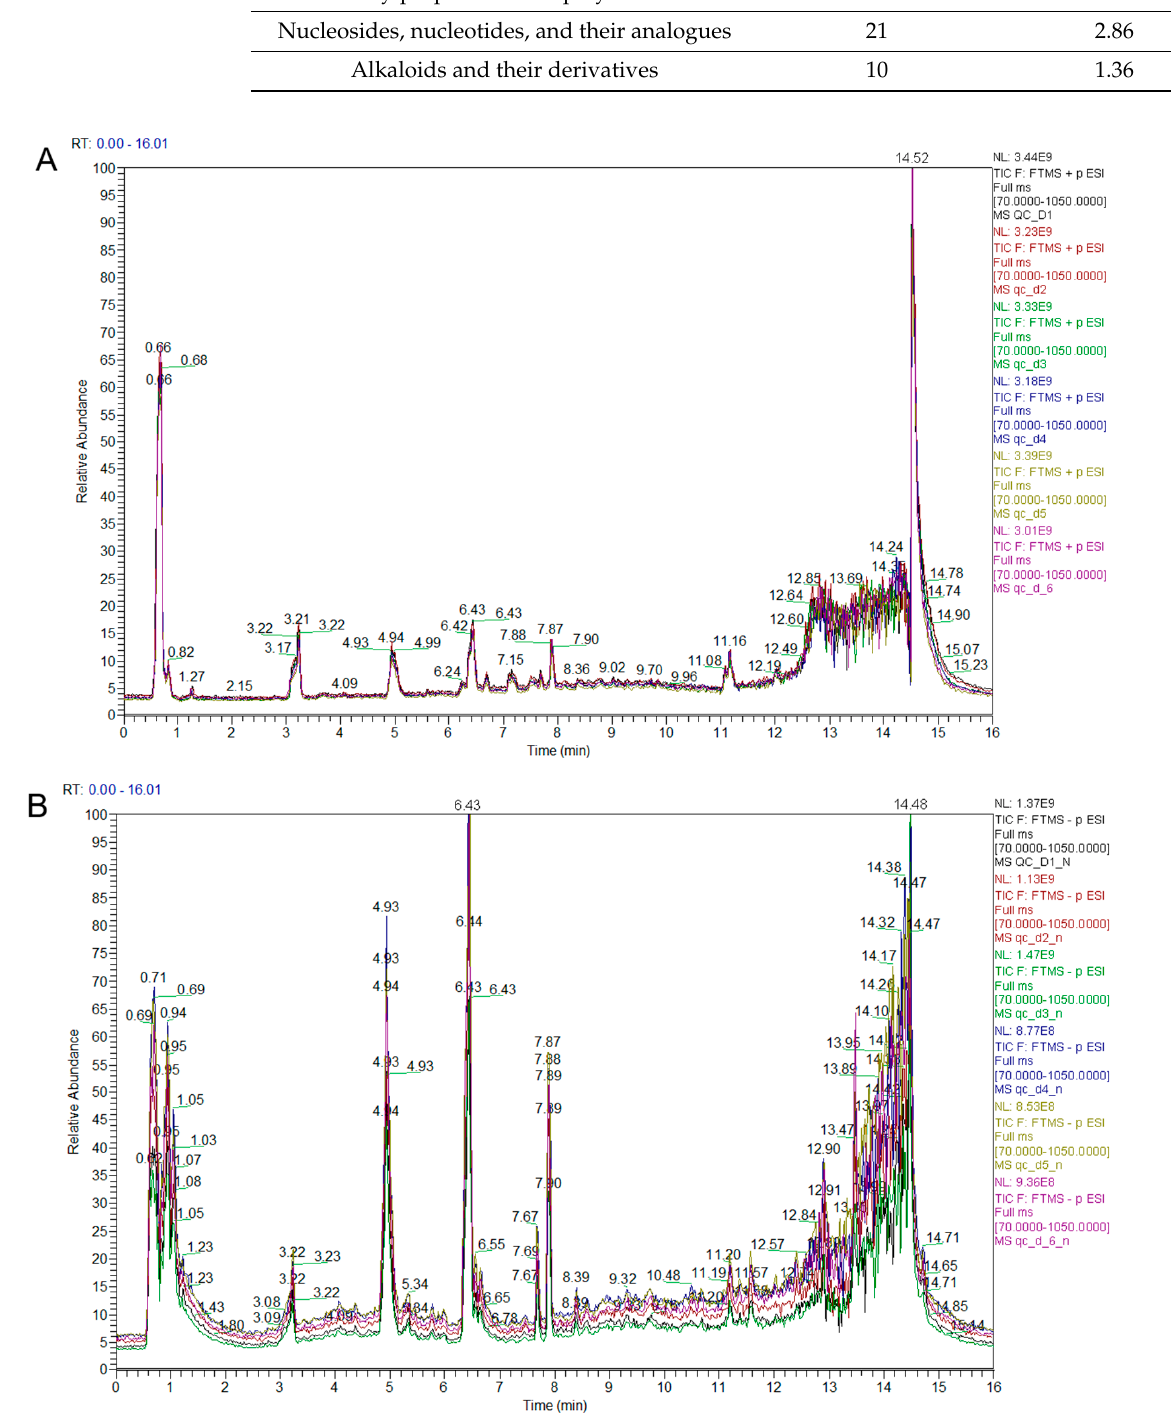
Figure 1. LC–MS chromatograms of the wheat grains’ metabolites ( X -axis = time and Y -axis = response. ( A ) Relative abundance of positive ions at different time intervals. ( B ) Relative abundance of negative ions at different time intervals. Table 1. List of various types of metabolites of Tilletia laevis Kühn.